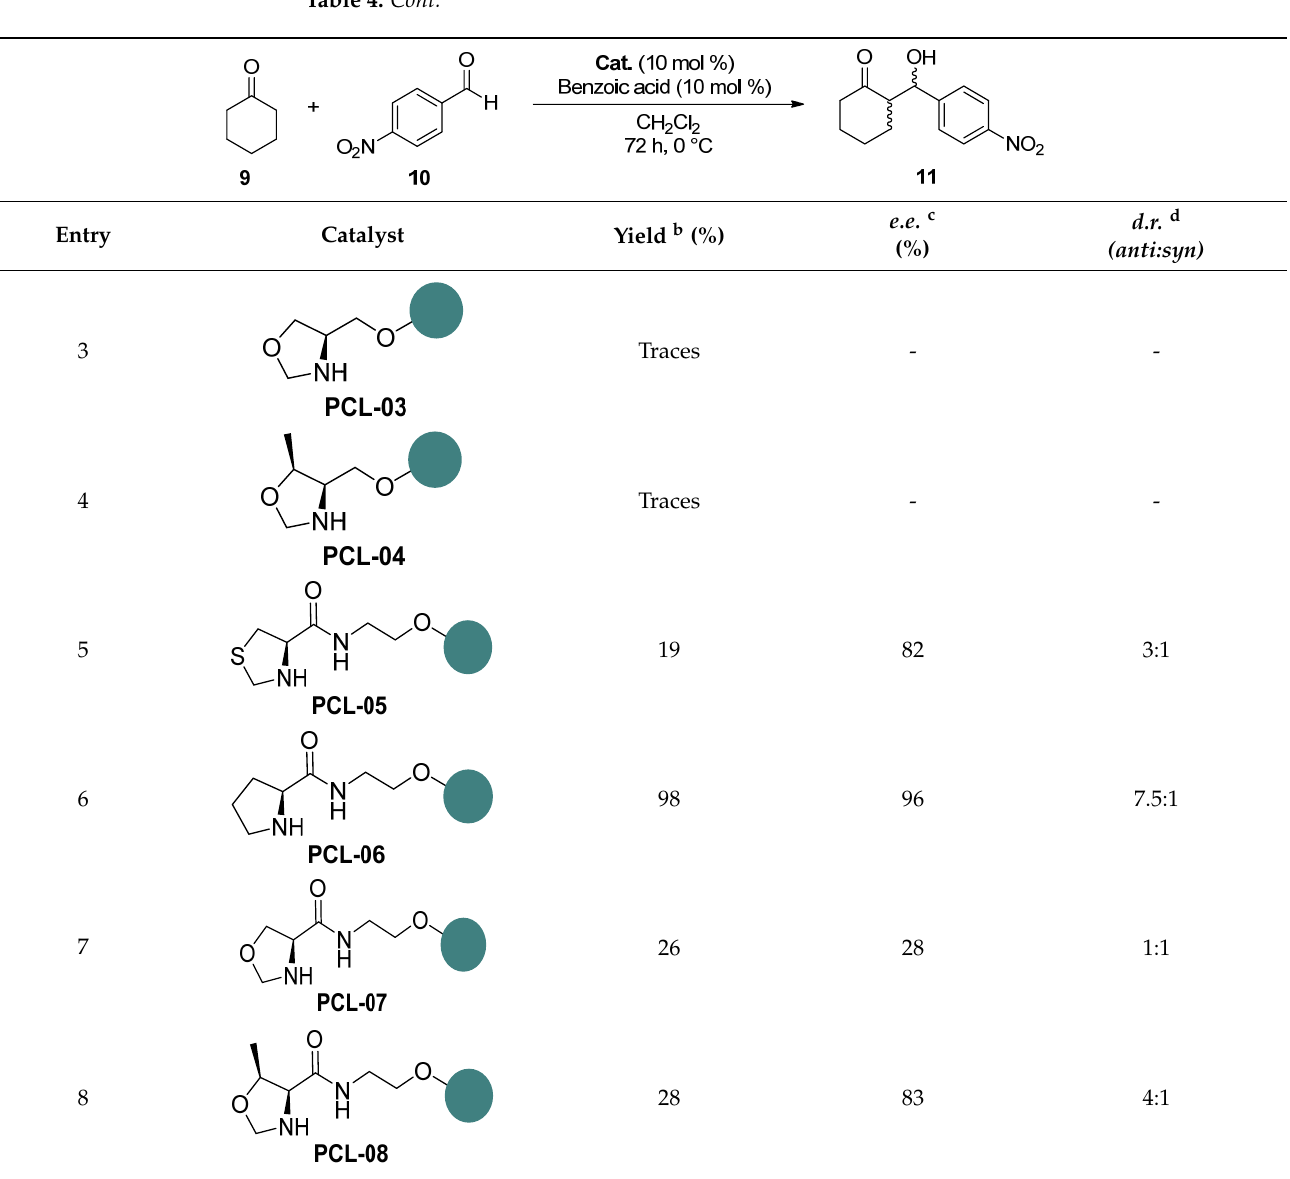
Table 5. Reuse of polymer PCL-06 in asymmetric aldol addition reaction.